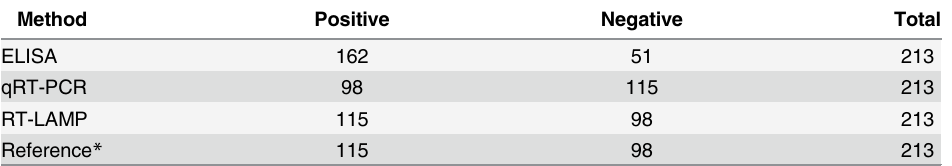
Table 2. Total dengue samples detected by ELISA, qRT-PCR and